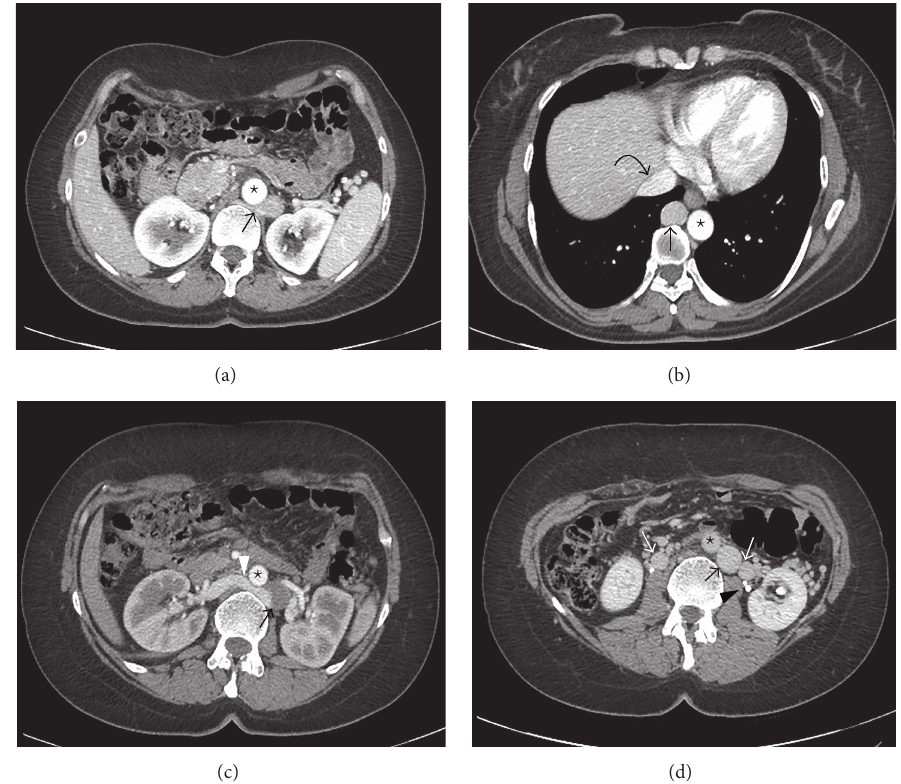
Figure 2: (a) Left IVC (black arrow) crosses the middle line behind the aorta (star). (b) Infrahepatic IVC drains into the Azygos vein (black straight arrow) that enters the thorax together with the aorta (star). Suprahepatic IVC (black curved arrow) is formed only from the hepatic veins and drains as usual into the right atrium. (c) Right renal vein (white arrowhead) crosses the middle line behind the aorta (star) to join the left IVC (black arrow). (d) Infrarenal IVC (black arrow) on the left side of the aorta (star). Large ovarian veins (white arrows) on both sides. Proximally duplicated left ureter (black